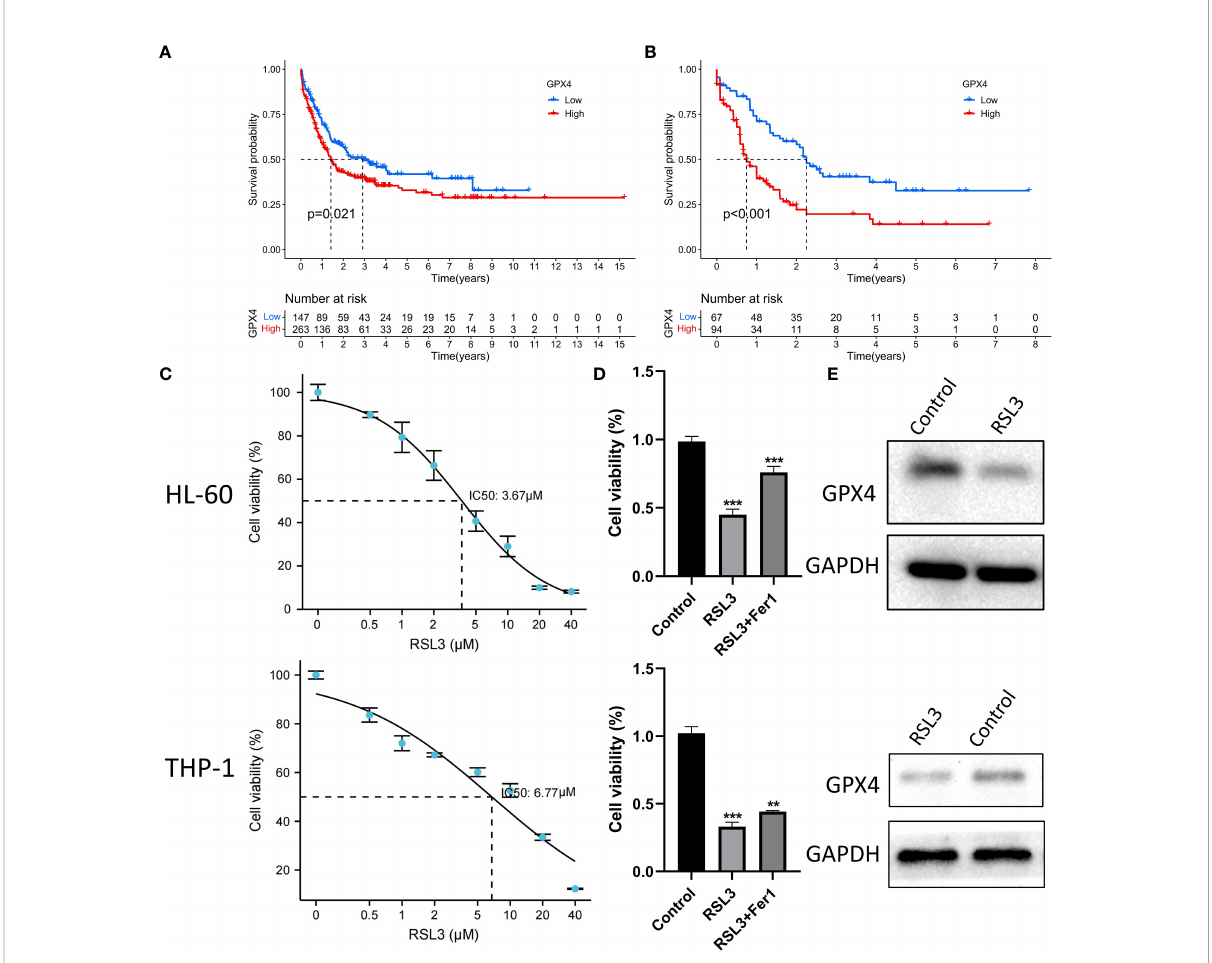
FIGURE 8 RSL3 inhibits growth of AML cells. (A, B) Differences in the survival of patients in high and low expression of GPX4 in the GEO and TCGA groups, A: GEO group, B: TCGA group, log rank test. (C) HL-60 cells and THP-1 cells were treated with RSL3 at the indicated doses for 48 h and cell viability was assayed using a CCK-8 kit. (D) HL-60 cells and THP-1 cell were treated with RSL3(HL-60: 5 m M; THP-1: 10 m M) with or without ferrostatin-1 for 48 h and cell viability was assayed, ***P < 0.001. (E) Protein level of GPX4 in HL-60 cells and THP-1 cells treated with RSL3 (HL- 60: 5 m M; THP-1: 10 m M) or control for 48 hours. **P <